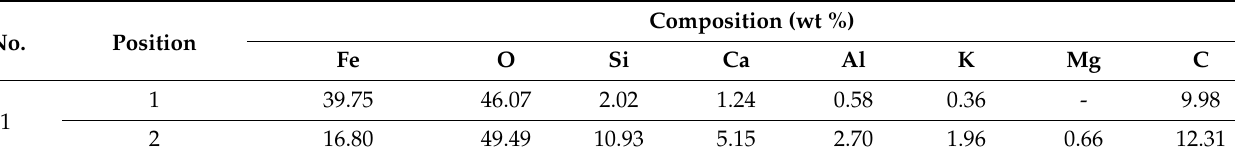
Figure 4. Microstructure and SEM image of spheroidal hammer scale (No. 1) ( a ) whole image, ( b ) metallographic microscope detailed image and rectangle is position of the SEM analysis, ( c ) position of SEM image and EDS analysis; 1: wüstite, 2: kirschsteinite.